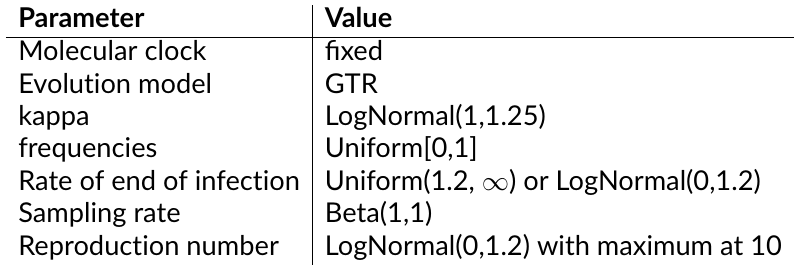
Table S2 – Prior summary for the BDSKY